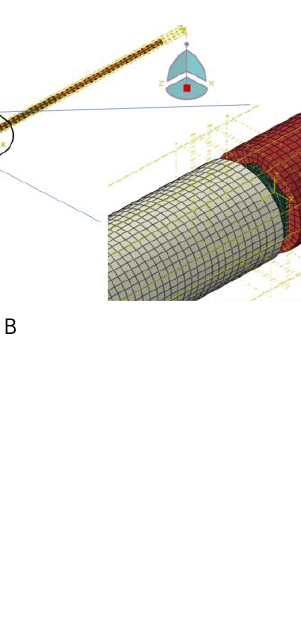
Fig. 4. Material data used for both bar and specimen The bars and specimen are meshed using C3D8R elements (8-node linear brick, reduced integration, hourglass control). The mesh size of the bars is 1mm and mesh size of the specimen is chosen to have four elements through the thickness in gauge section of the specimen. The meshed model is presented in Fig.5. The meshed specimen is shown in Fig.6.